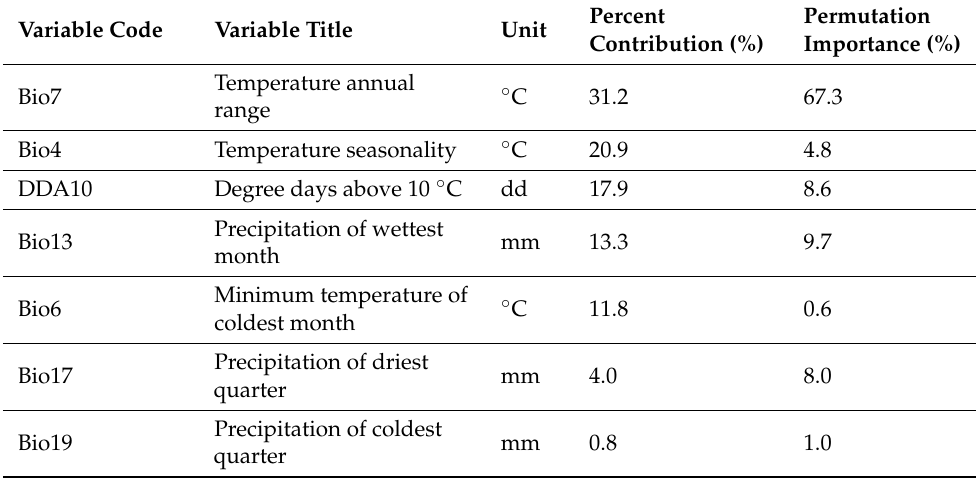
Table 4. Percent contribution and permutation importance of environmental variables used to predict location suitability for Thaumatotibia leucotreta in